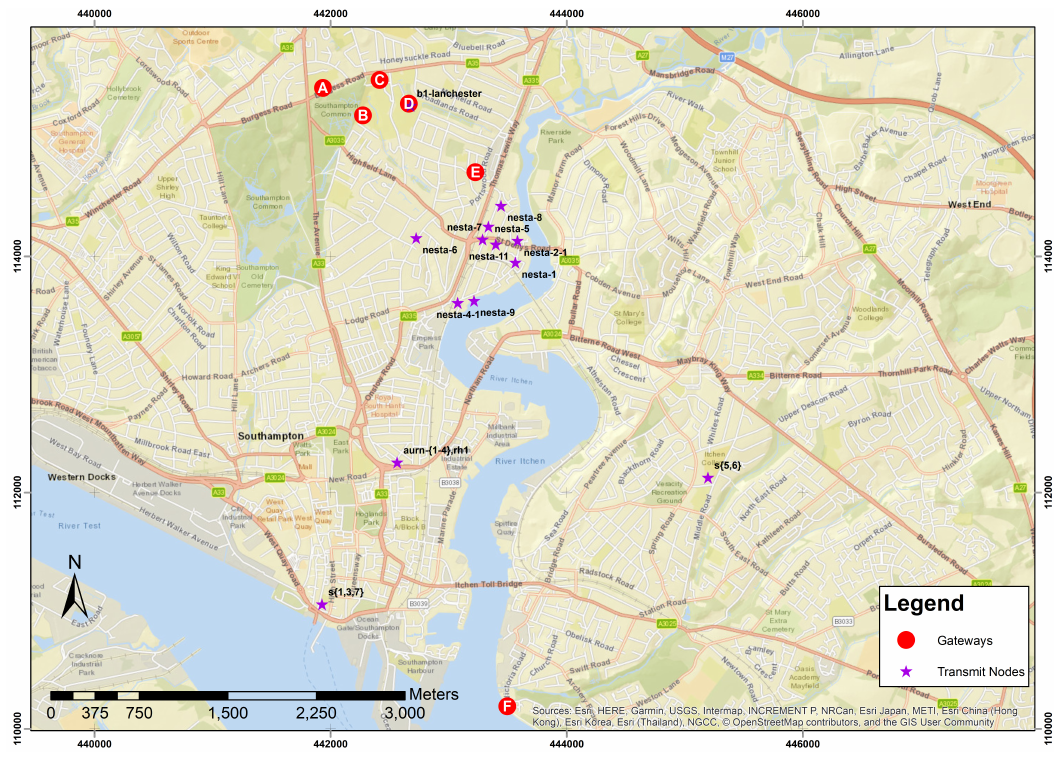
Figure 1. Map showing locations of nodes transmitting LoRaWAN messages and the gateways receiving them. See Table 2 for details of messages transmitted. Table 5. LoRaWAN base stations located in the city of Southampton, including third party hardware. The Kerlink iBST supports antenna diversity but not all are equipped with dual antenna.